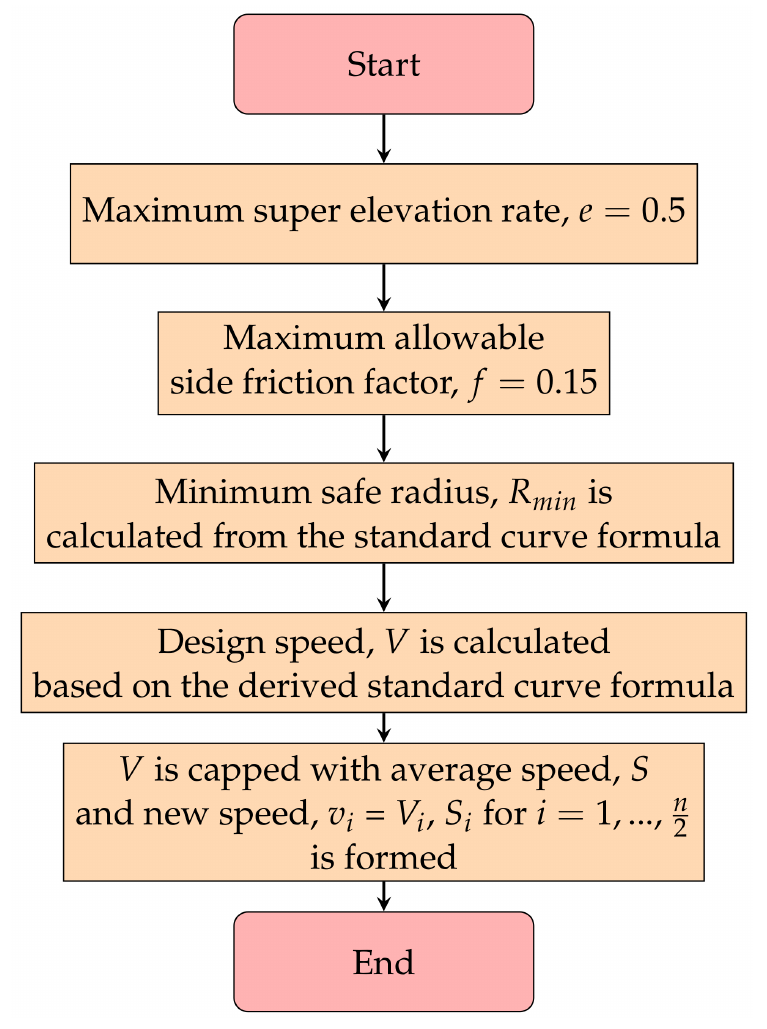
Figure 6. Flowchart for calculating design speed capped by the average